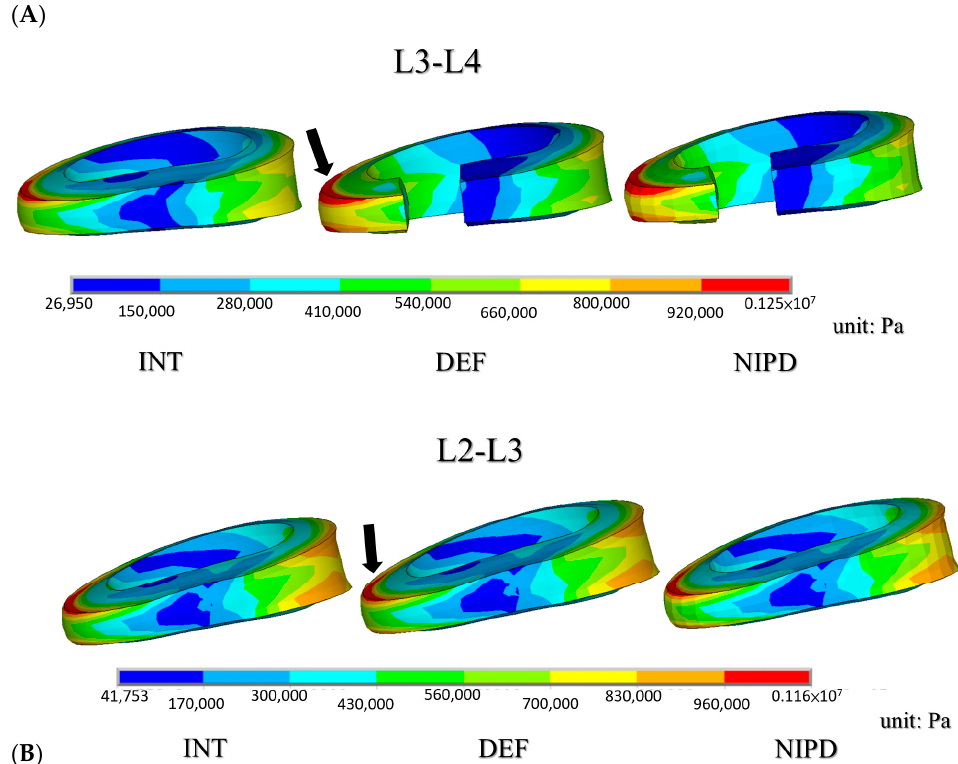
Figure 8. Disc stress distribution in the three FE models in lateral bending: ( A ) implanted level L3–L4 and ( B ) adjacent level L2–L3. Note: the arrow indicates the region of high stress. Table 5. Comparison of biomechanical characteristics among the three FE models in